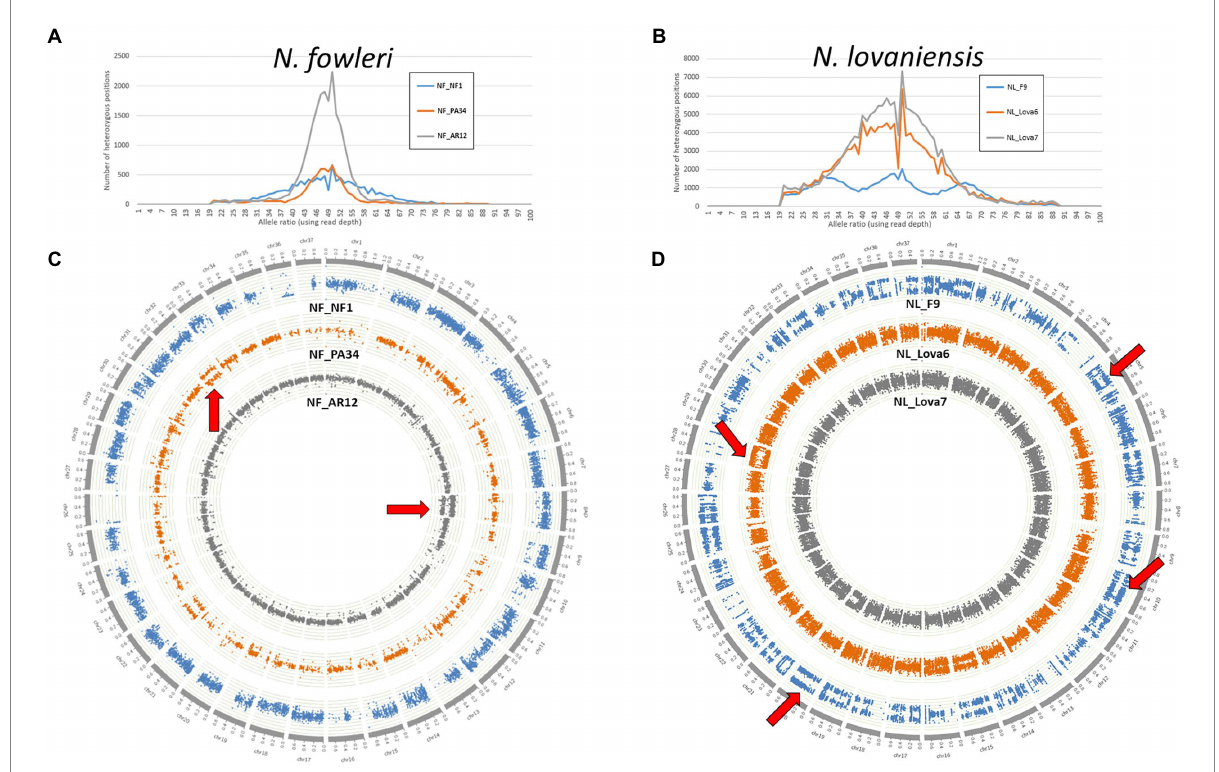
FIGURE 3 The ploidy patterns of the newly sequenced genomes from Naegleria fowleri and Naegleria lovaniensis . (A,B) Frequency distribution of SNP allele ratios and (C,D) circos scatter plots showing allelic ratios of heterozygous SNPs along chromosomes analyzed in N. fowler i NF_NF1, NF_PA34 and NF_AR12 strains (left panel) and N. lovaniensis NL_F9, NL_Lova6 and NL_Lova7 strains (right panel). Examples of suspected aneuploidy areas are highlighted by red